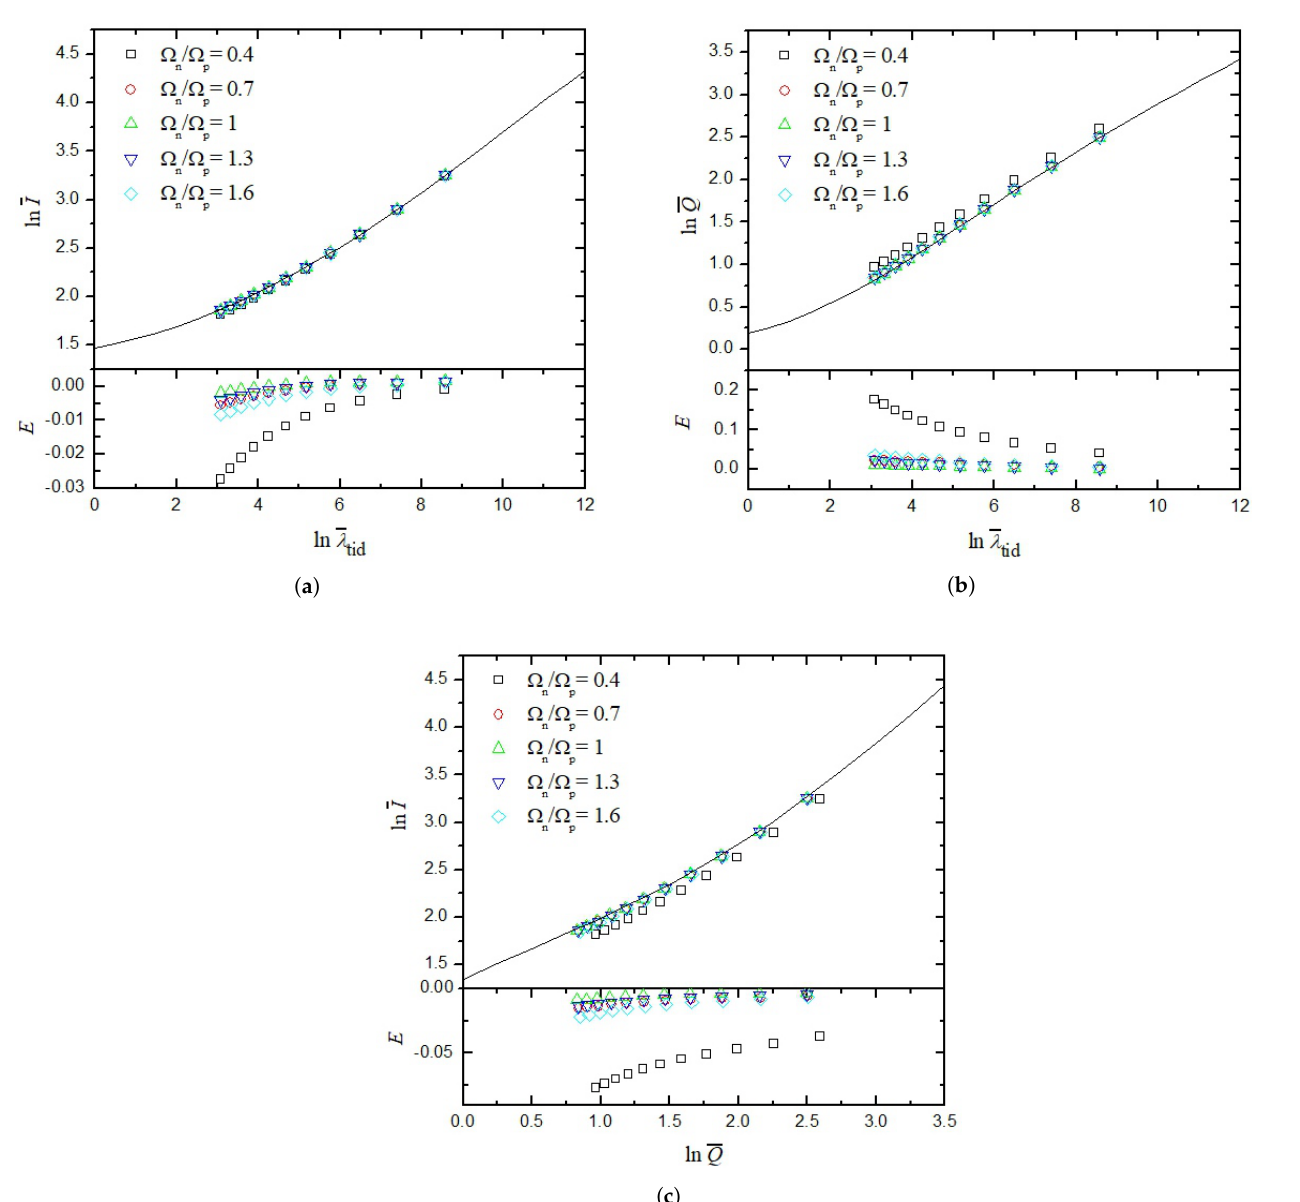
Figure 2. The accuracy of the I-Love ( a ), Q-Love ( b ), and I-Q ( c ) relations for our chosen two-fluid polytropic EOS using different spin ratios Ω n / Ω p . The solid line in the upper panel of each figure represents the corresponding fitting curve for ordinary single-fluid neutron stars [14]. The lower panel of each figure shows the relative error between the two-fluid results and the corresponding fitting